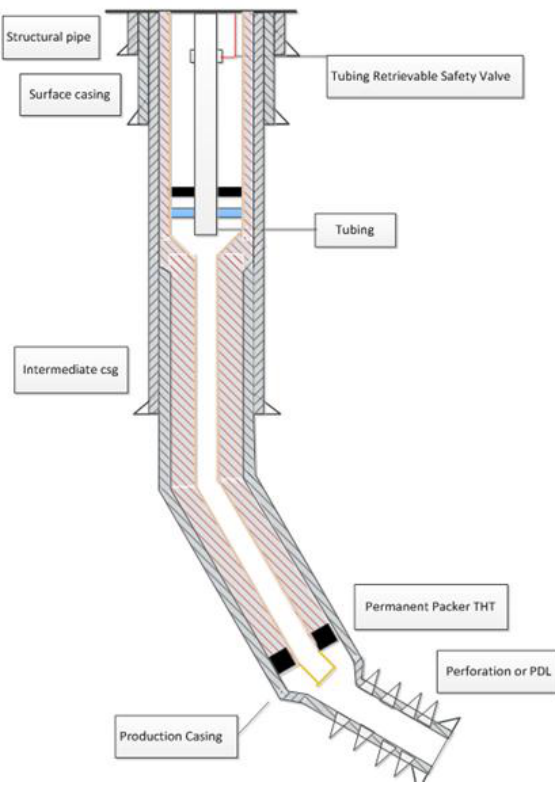
Figure 2—Typical Wellbore